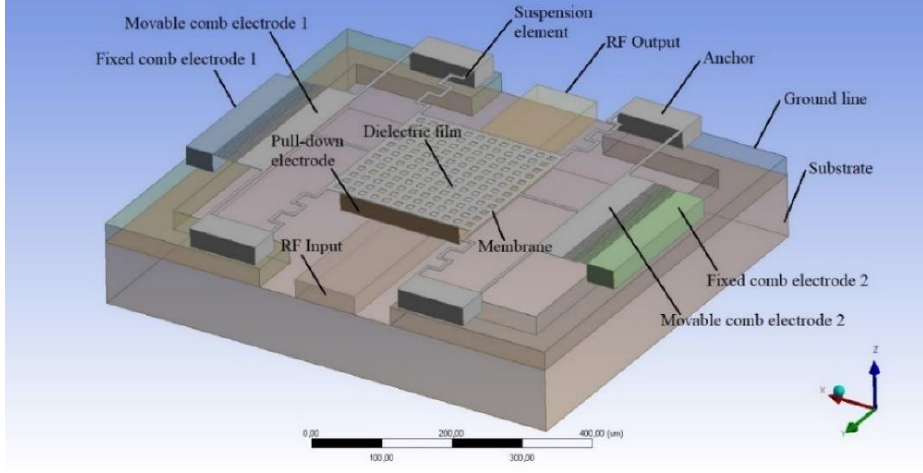
Fig. 1. Design and main elements of MEMS